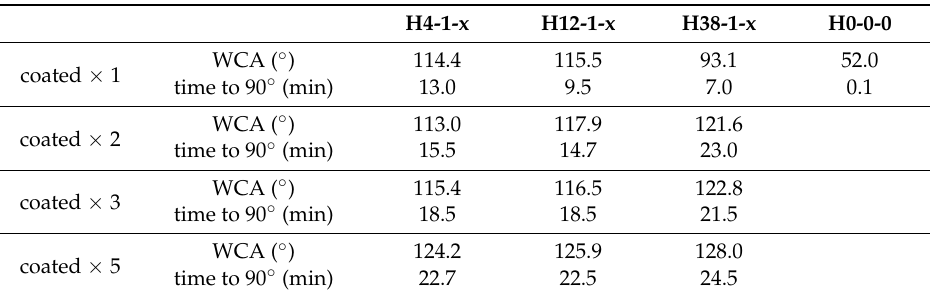
Figure 6. WCA and time measurements for the series of samples H4-1-x, H12-1-x, H38-1-x, and H0-0-0, showing the beneficial effect of the quantity of silica applied onto the hemp shiv on both the WCA, and the period of sustained water repellence. Table 2. Summary of results, after Figure 6.